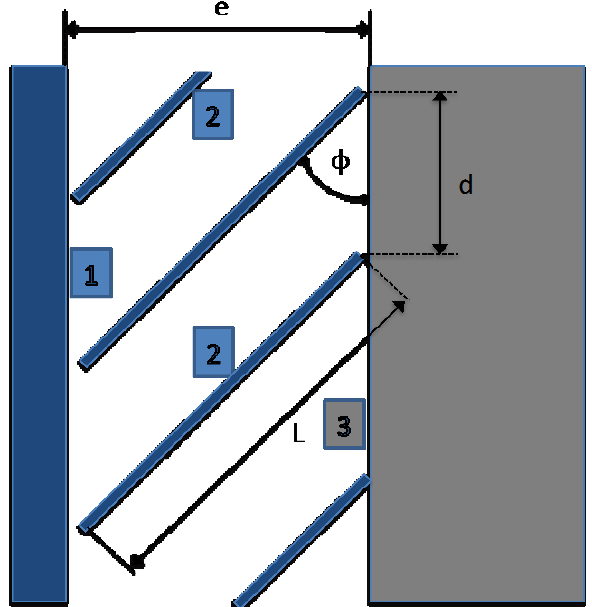
Figure 1. Façade diagram: plan view: ( 1 ) Outer element; ( 2 ) the fins; and ( 3 ) the inner element. The vertical air chamber runs along the entire façade. The rectangular membranes forming the fins bear PCMs. Air flows upward in the